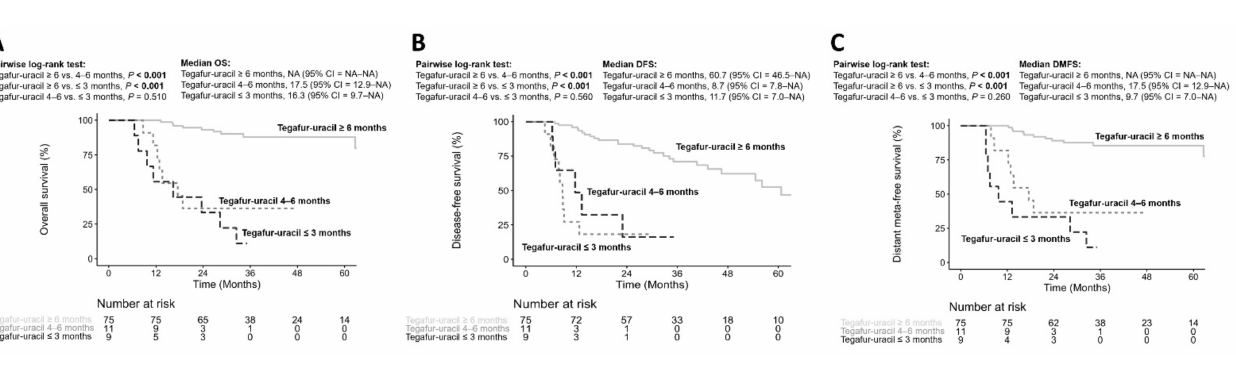
Figure 3. Analyses for the different duration of tegafur–uracil administration on overall survival ( A ), disease-free survival ( B ) and distant meta-free survival ( C ).